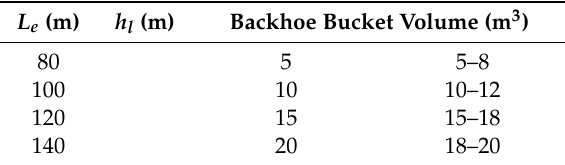
Table 1. Length of the exit L e for different layer’s height h l and backhoe’s bucket volume.